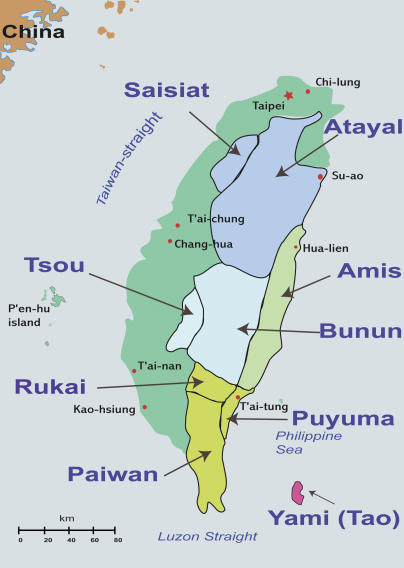
Ancient mitochondrial DNA from these nine indigenous Taiwanese tribes provided clues about their movement throughout Polynesia